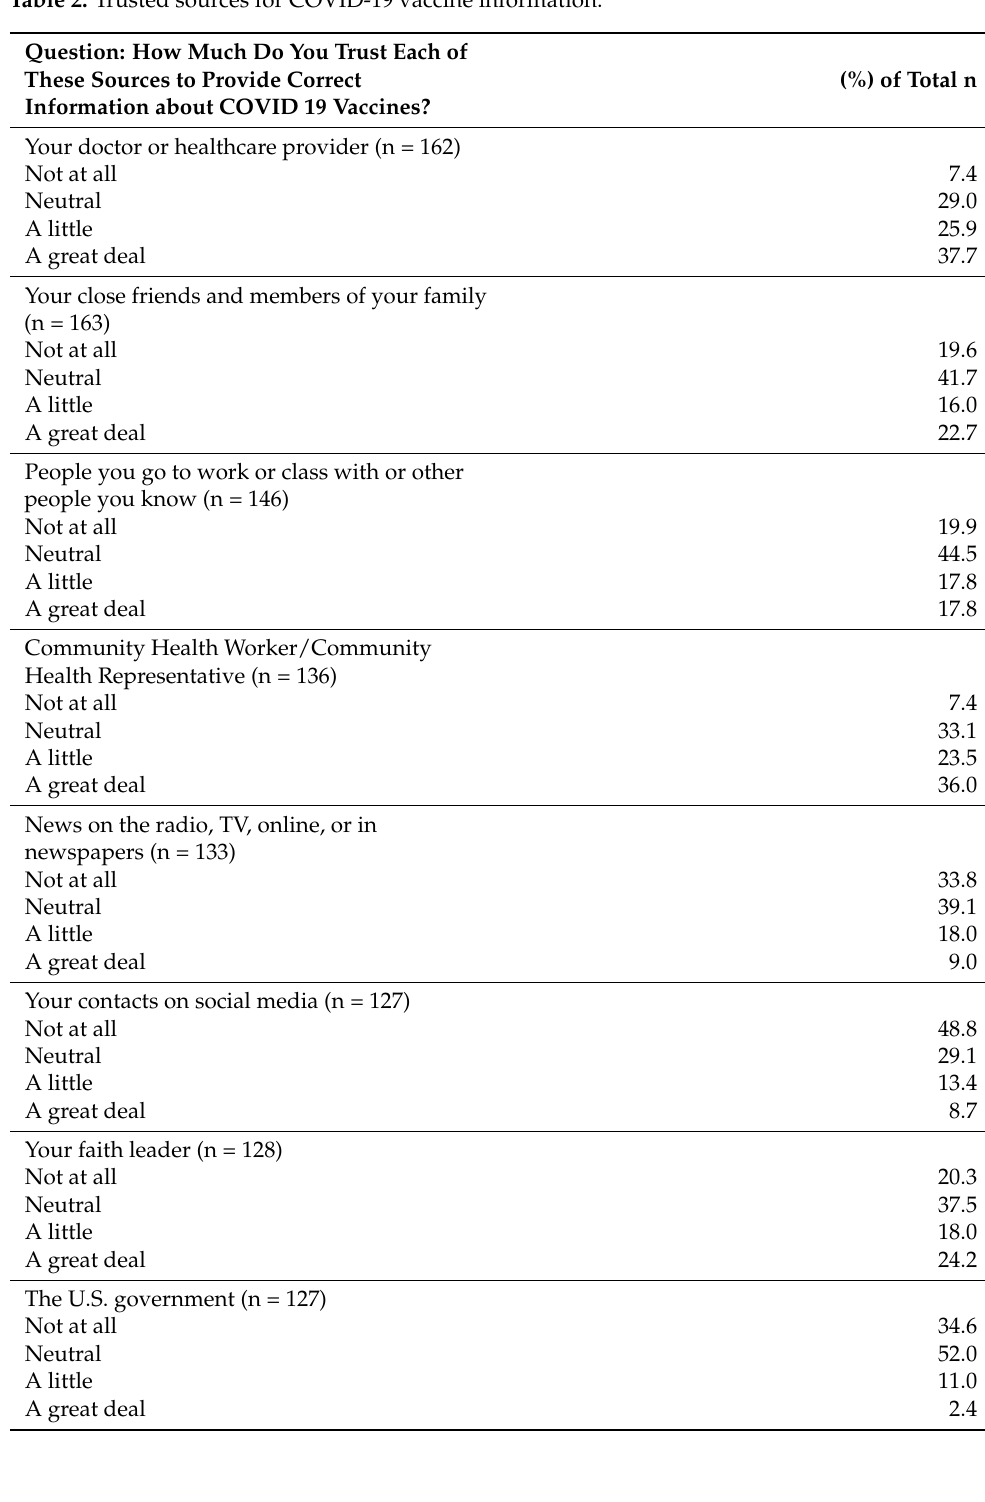
Table 2. Trusted sources for COVID-19 vaccine